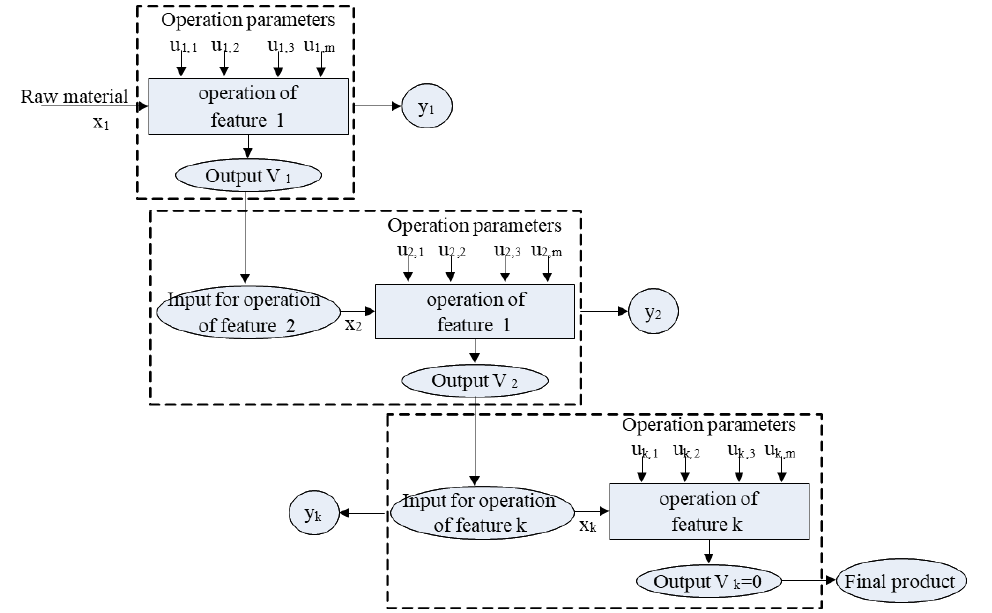
Figure 6. Illustration of the ECM for a feature sequence candidate.